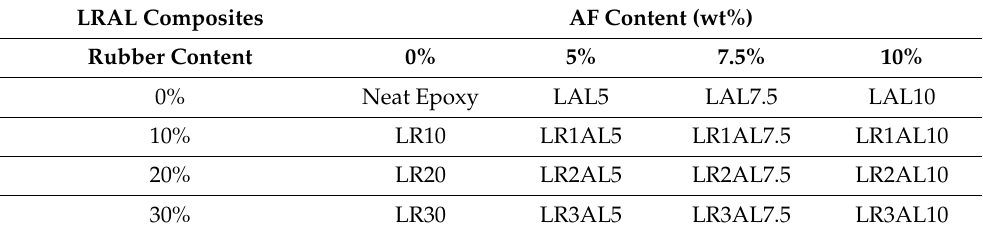
Table 8. Composition of the alumina fiber reinforced composites [56].